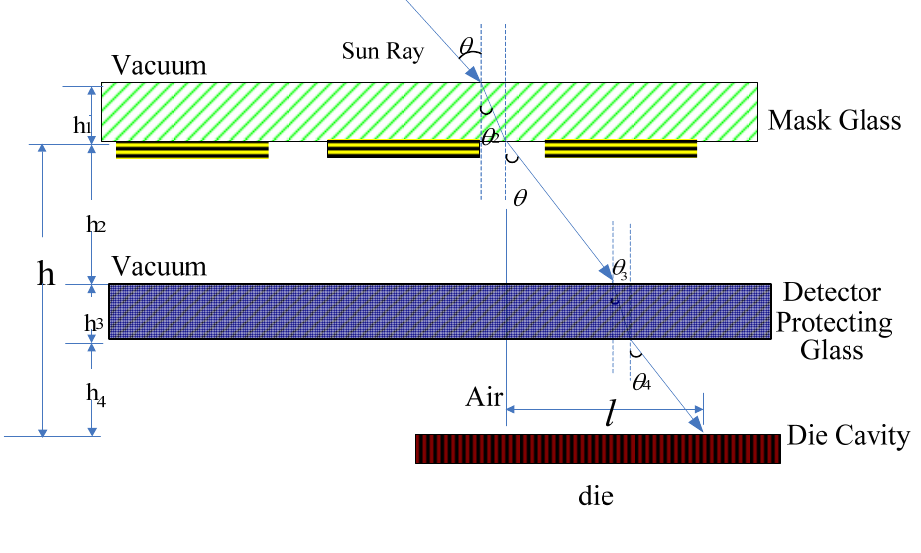
Figure 3. illustration of the sunray tracking route in the sun